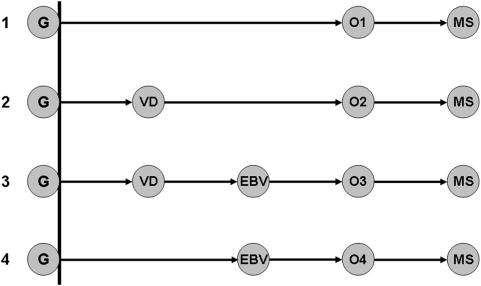
Possible causal pathways (1–4) leading to MS, which include genetic factors (G), vitamin D deficiency (VD), Epstein-Barr virus (EBV) infection, and other unidentified environmental factors (O1–O4).The other environmental factors along the different pathways to MS have been designated O1–O4 because these relevant (but unknown) factors need not be the same along each path. In the Figure, the first two environmental events are represented as an appropriately‐timed vitamin D deficiency and an appropriately‐timed EBV infection. However, the association of these specific events with the first and second environmental events (discussed in the text) is not a necessary part of the Model itself.